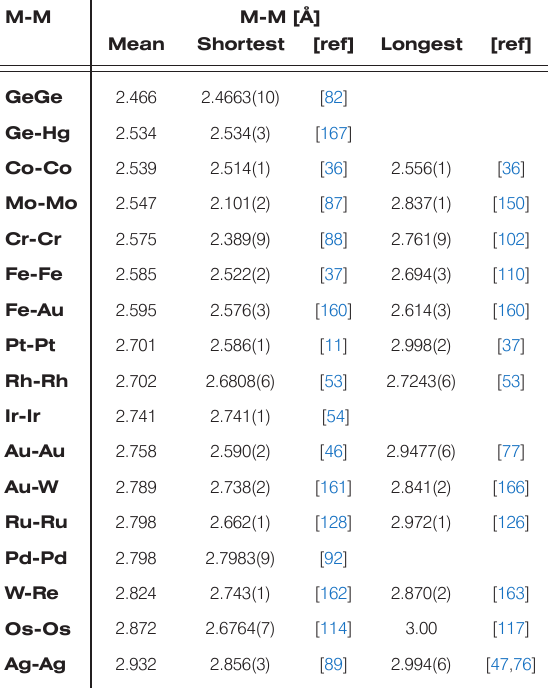
of Mean M-M bond distances for Heterotetranuclear